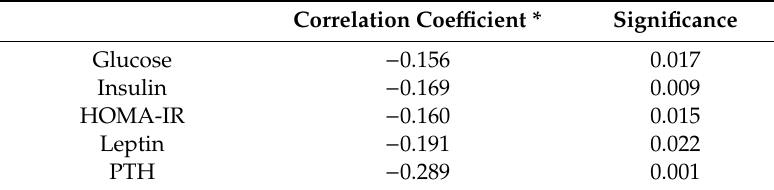
Correlation Coe ffi cient